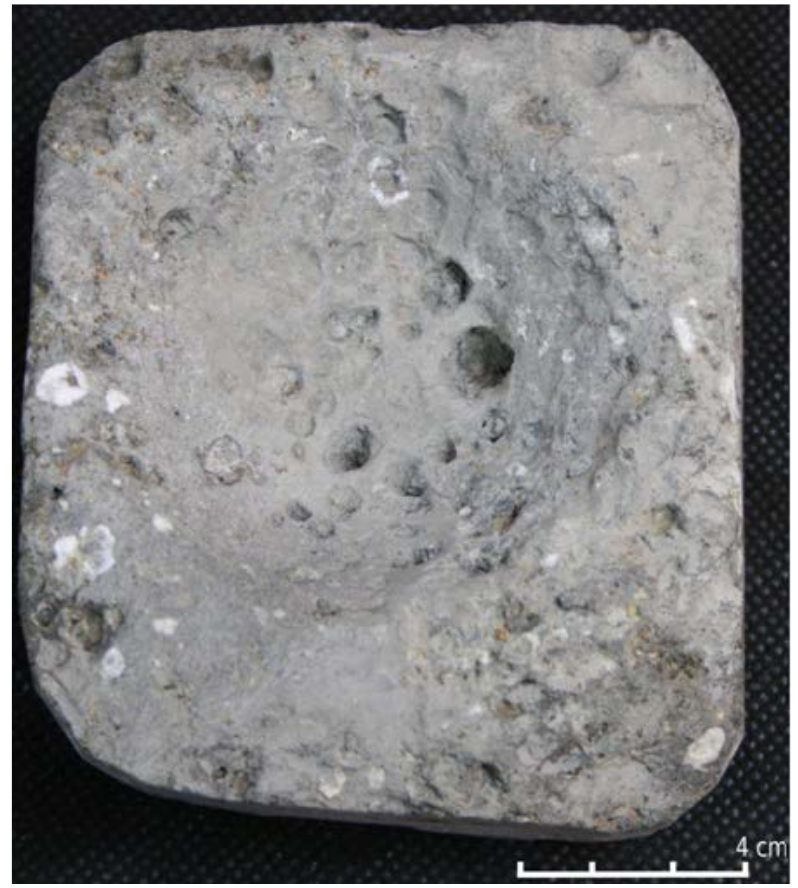
Figure 6. The mortar’s cavity after being cut from the cobble at the end of the